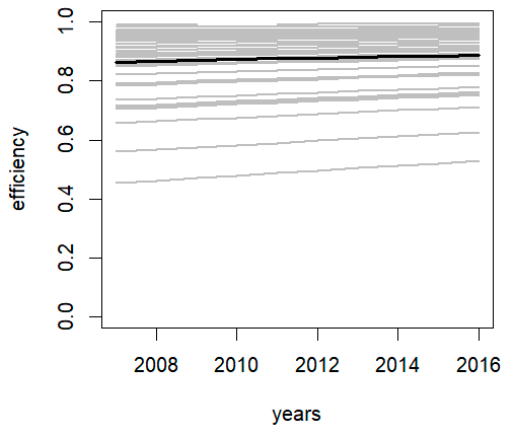
ffi ciencies for the period of Figure 11. Estimated efficiencies for the period of 2007–2016. Figure 11. Estimated e